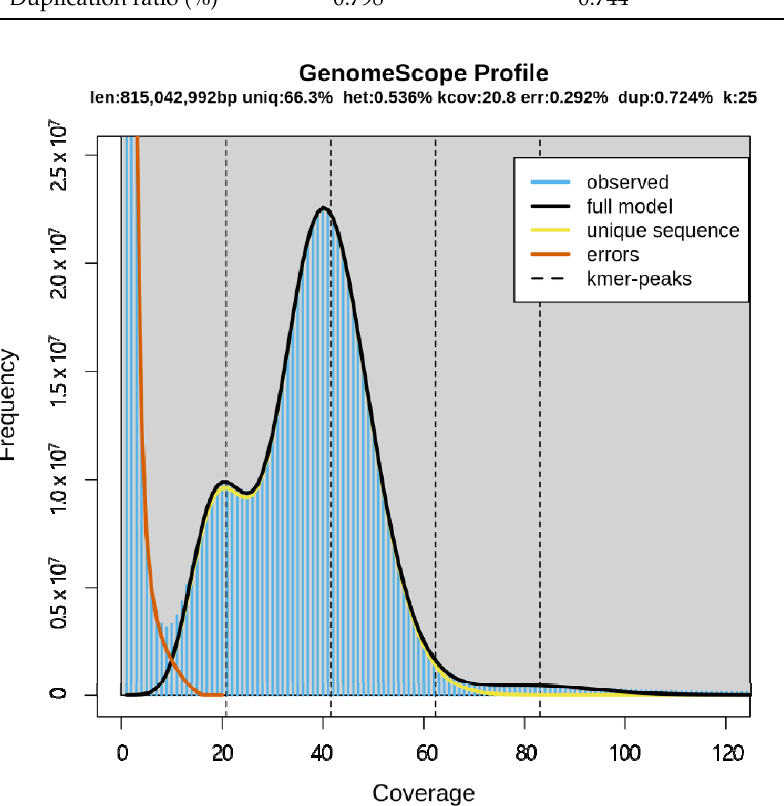
Figure 2. K-mer analysis (K = 25) of T. loennbergii . The X -axis represents coverage, and the Y -axis represents the frequency at each depth. This profile plot shows the fit of the model (black) to the observed frequency (blue).